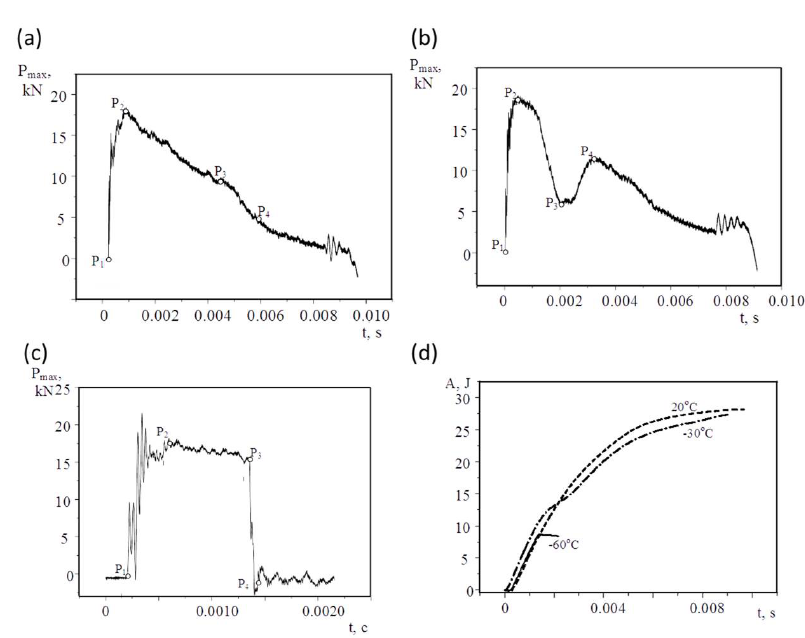
Figure 5. Dynamic influence on Charpy specimens (type II, see Figure 1) at 20 ◦ C (a), -30 ◦ C (b), -60 ◦ C (c) and variation of energy to failure with time (d)